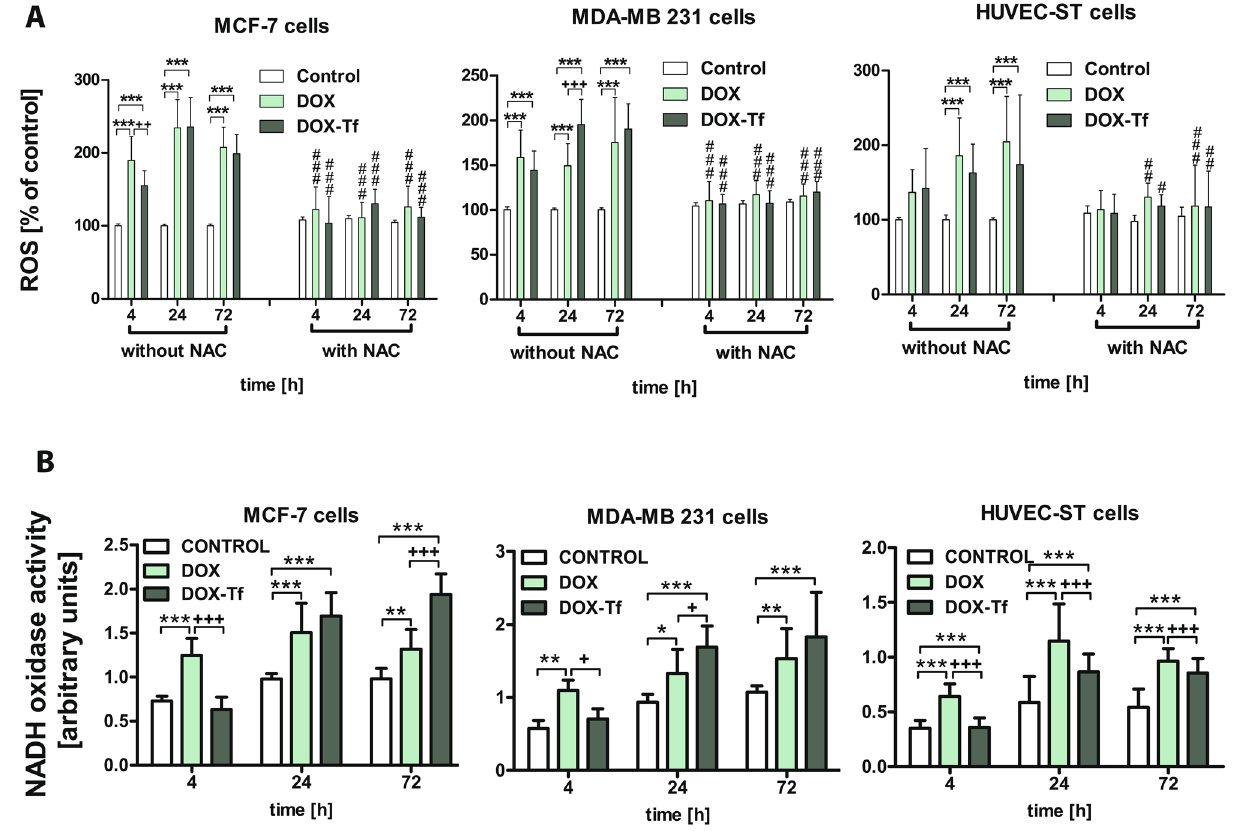
Figure 3. Oxidative stress markers in MCF-7, MDA-MB-231 and HUVEC-ST cell lines treated with DOX– Tf conjugate or DOX alone for 4, 24 and 72 h. ( A ) Cellular ROS level assessed by H 2 DCFDA oxidation after treatment of MCF-7, MDA-MB-231 and HUVEC-ST cells with DOX–Tf conjugate or free DOX (IC 50 dose) for 4, 24 and 72 h in the absence or presence of ROS scavenger NAC (5 mM). ( B ) Activity of NADH oxidase in MCF-7, MDA-MB-231 and HUVEC-ST cells was measured after 4, 24 and 72 h exposure of cells to free DOX and DOX–Tf conjugate. Data represent mean ± SD of four independent experiments. * p < 0.05, ** p <